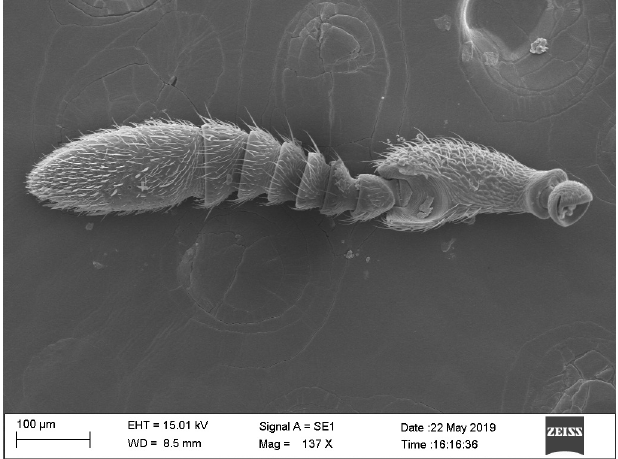
Fig 4 . Ooceraea octoantenna Zhou & Chen sp. nov., funiculus of antenna, in ventral view.